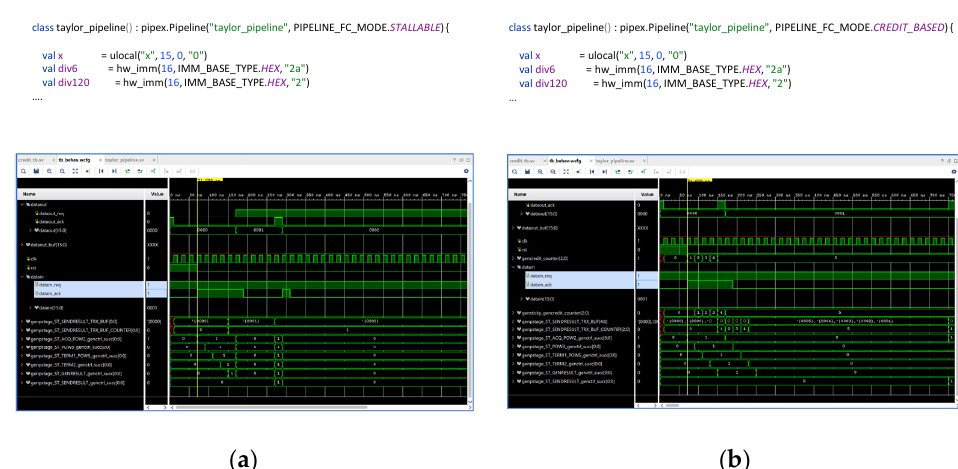
Figure 6. Flow control options provided in Pipex KIP core: stall-based ( a ), credit-based ( b ).